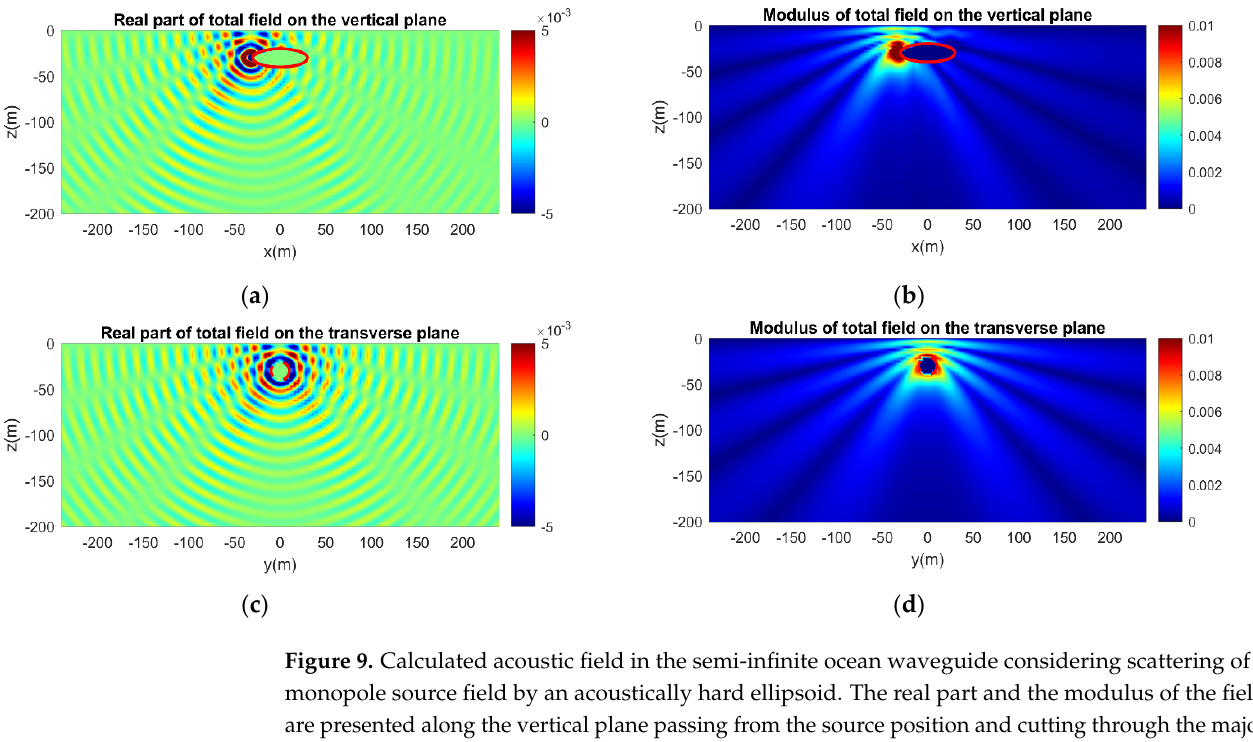
Figure 9. Calculated acoustic field in the semi-infinite ocean waveguide considering scattering of a monopole source field by an acoustically hard ellipsoid. The real part and the modulus of the field are presented along the vertical plane passing from the source position and cutting through the major axis of the ellipsoid and on the transverse plane passing from the source position in front of the ellipsoid. ( a ) Real part and ( b ) modulus of the acoustic field on the vertical plane. ( c ) Real part and ( d ) modulus of the acoustic field on the transverse plane.